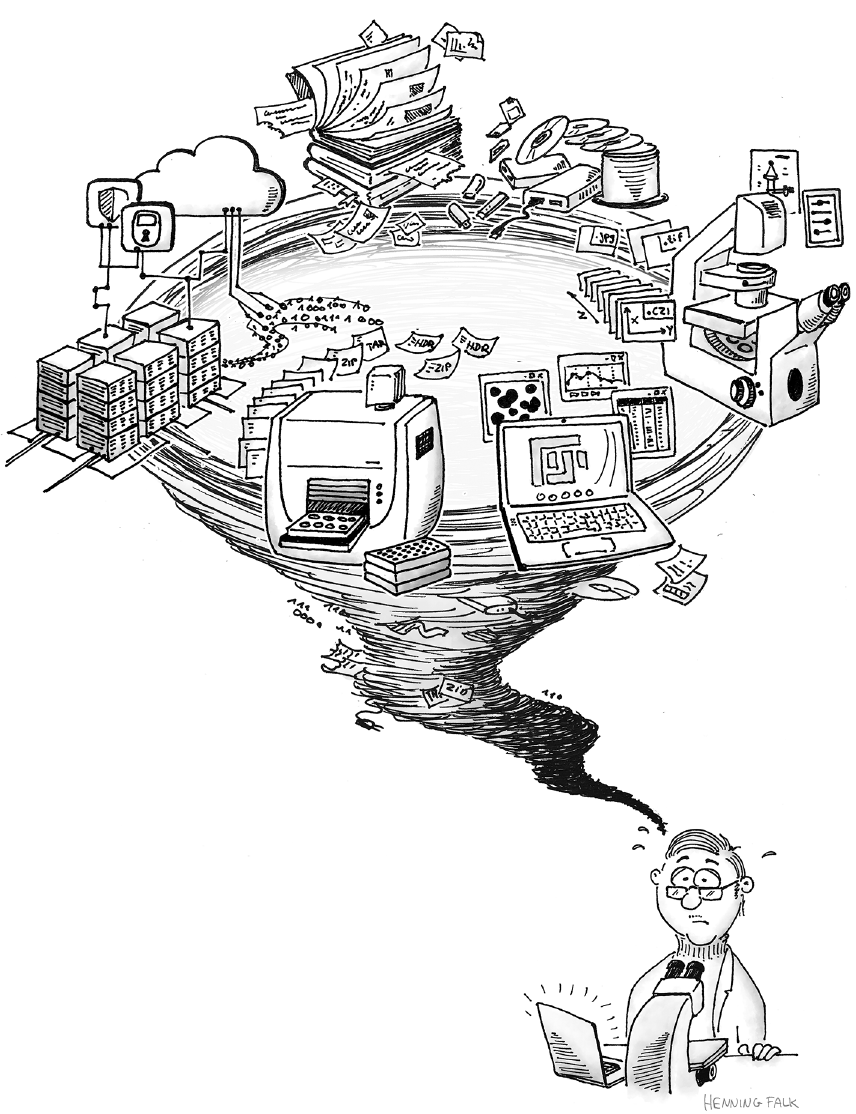
Figure 9. Proper handling of large-scale, complex data as frequently acquired in bioimaging is a challenge for researchers, dataproviders, and data users. Targeted measures must rely on afirm knowledge of the community perspective and its needs to transform the research data management whirlwind into a well-managed bioimage data life cycle (cartoon produced by Henning Falk for this article and published with